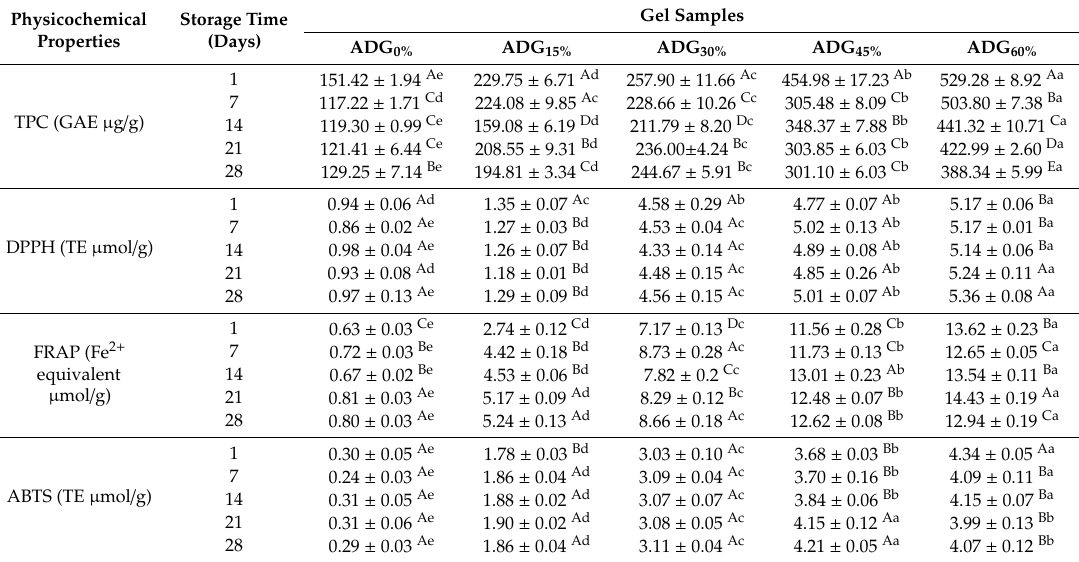
Table 3. Total phenolic content and antioxidant capacity of stirred